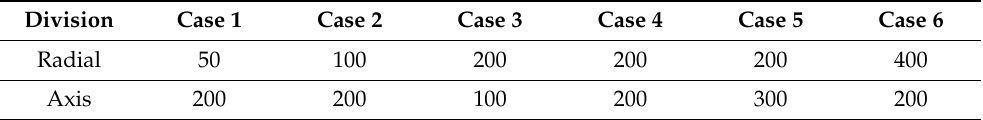
Table 3. Mesh cases for model validation with the SPACE